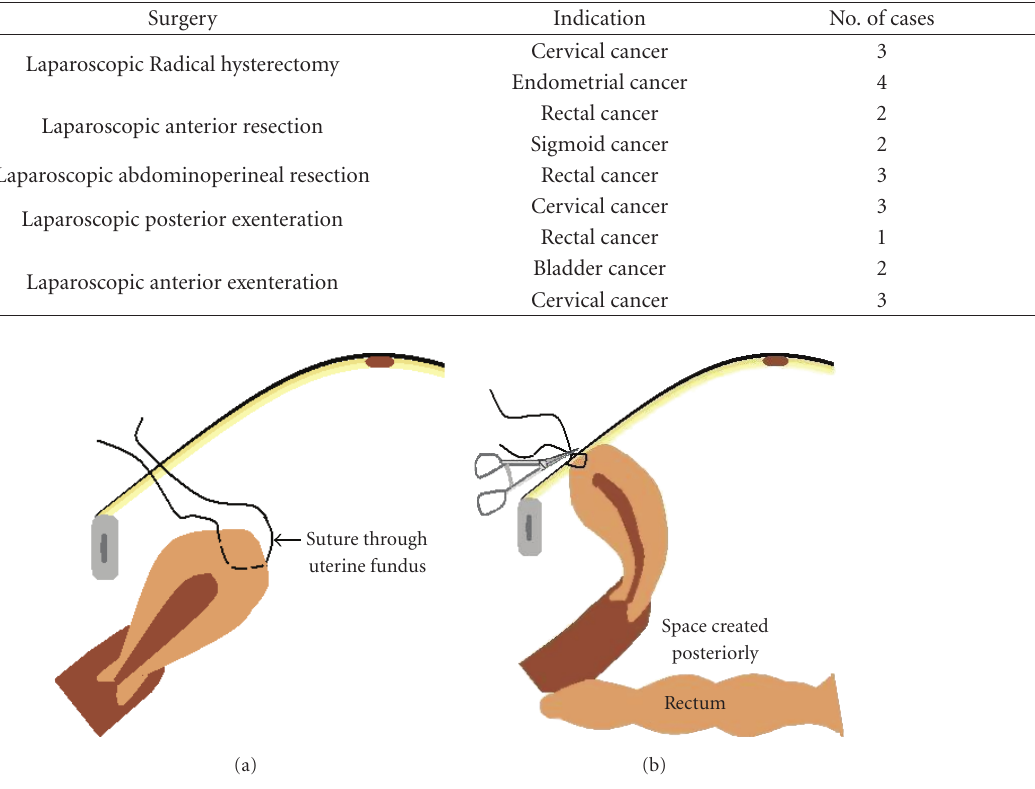
Figure 1: A diagrammatic representation of the uterine hitch technique. (a) Suture passed though the musculature of the uterine fundus. (b) The uterus is hitched to the anterior abdominal wall. A haemostatic forceps is applied to both at the ends. A pull on the sutures will antevert the uterus and displace it anteriorly.